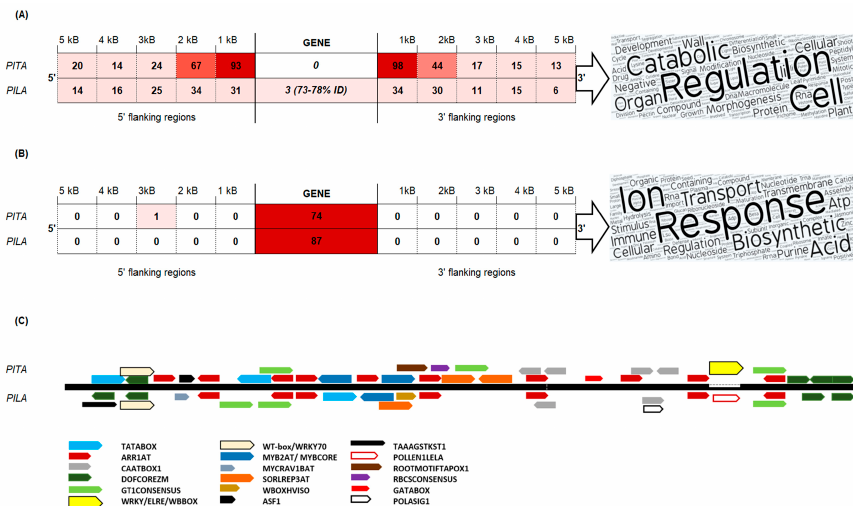
Figure 3. ( A ) Distribution of Plater MITE insertions across P. taeda (PITA) and P. lambertiana (PILA) gene-flanking regions. ( B ) Distribution of Plater MITE insertions across P. taeda (PITA) and P. lambertiana (PILA) gene introns. World cloud generated from biological process GO terms of P. taeda genes involved in the networks using the online tool https://wordart.com/. ( C ) Alignment of P. taeda (PITA) and P. lambertiana (PILA) consensus sequences with predicted plant cis-acting regulatory elements.